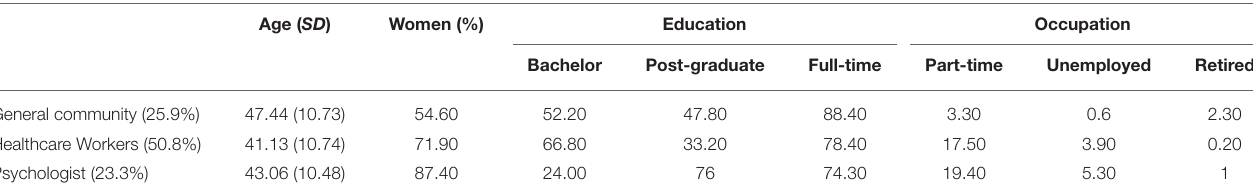
TABLE 1 | Descriptive data across groups under